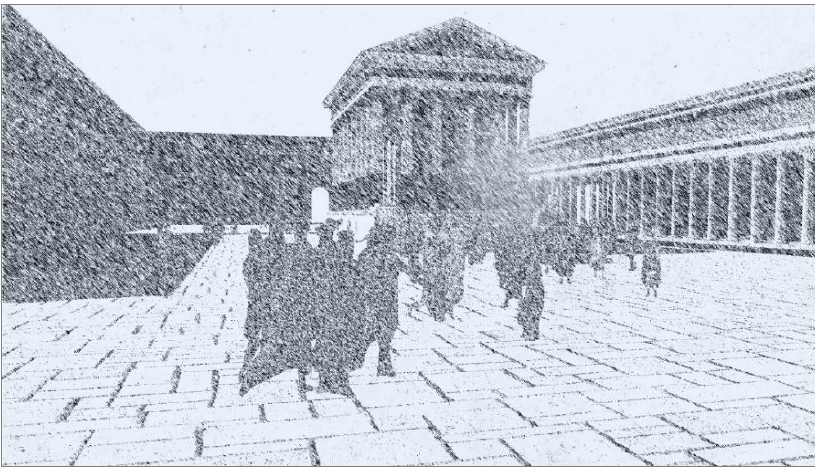
Figure 11 Scene 5: Thematic Reanimation of Podium Temple and the